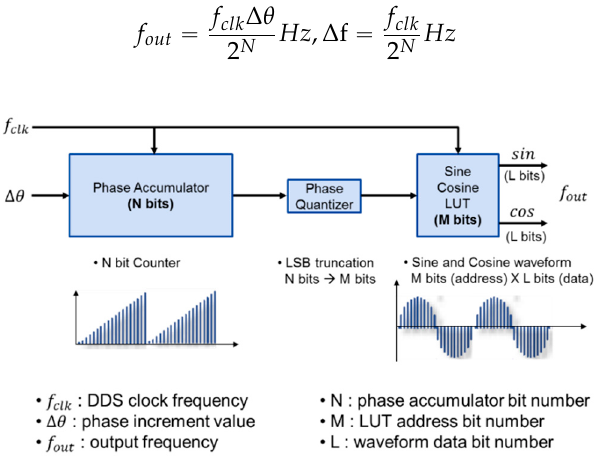
Figure 9. The structure of the DDS (Direct Digital Synthesis).